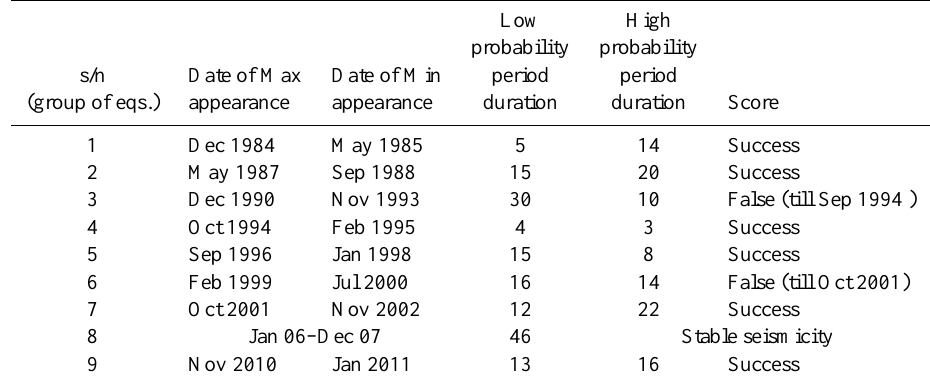
Table 2. Dates of the appearance of the relative maximum and minimum of the log E 2 / 3 time series and the low and high probability periods duration. Low High probability probability s/n Date of Max Date of Min period period (group of eqs.) appearance appearance duration duration Score 1 Dec